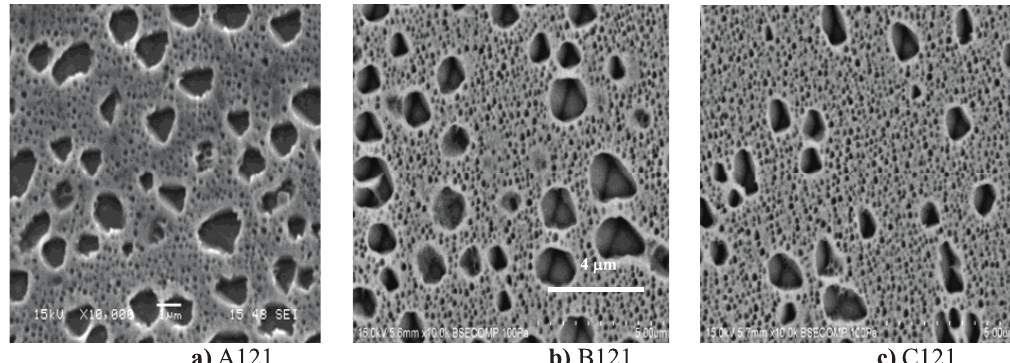
Figure 25. Microstructures of specimens after reheat treatment of Program 10.